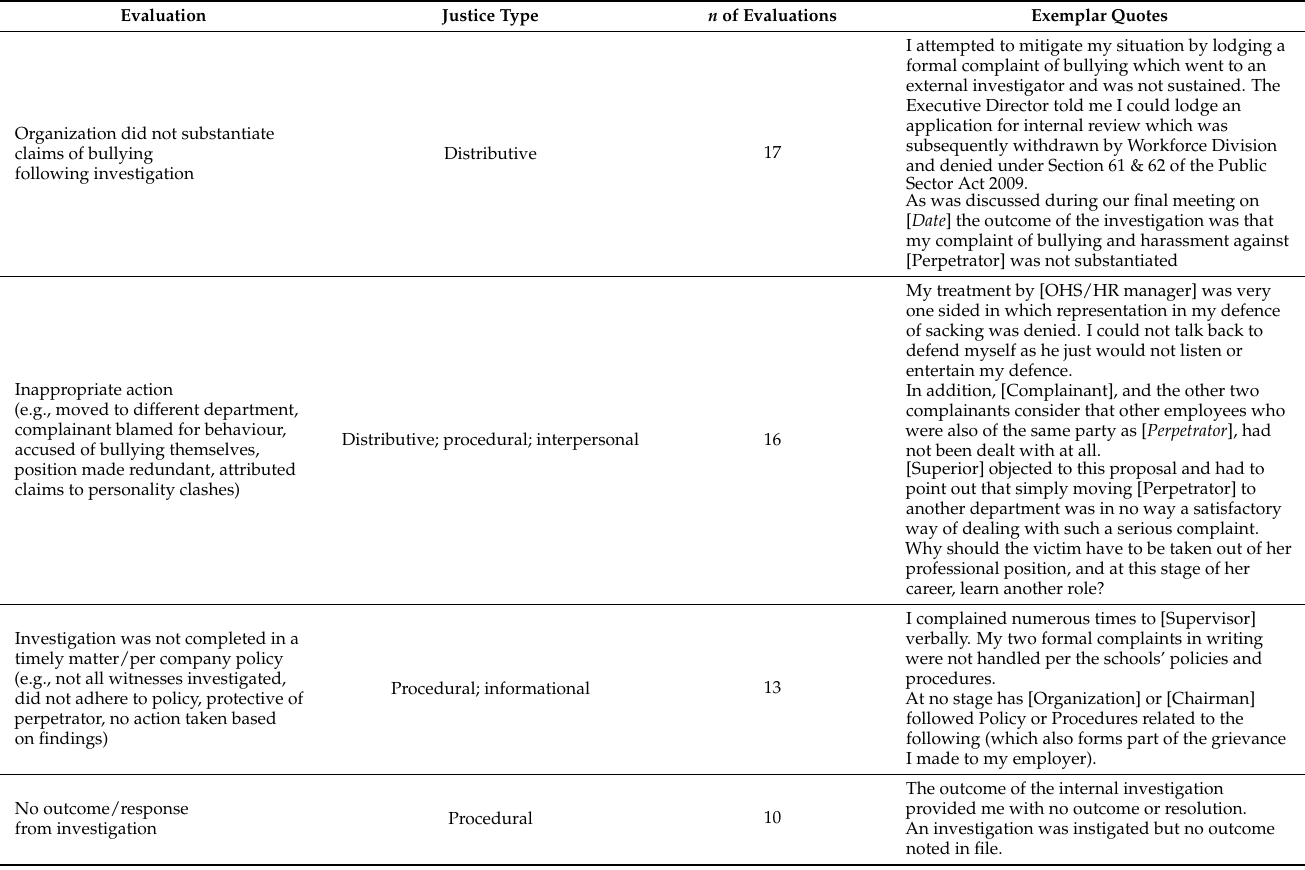
Table 7. Triggers of Justice Reactions in the Internal Investigation